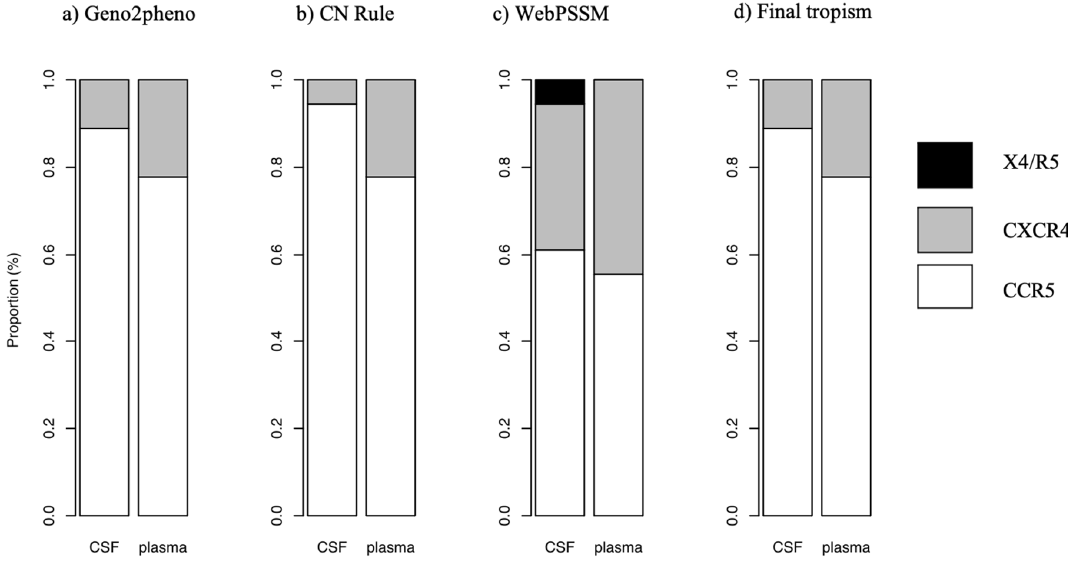
Figure 3. Comparison of co-receptor usage in CSF and plasma using ( a ) Geno2Pheno, ( b ) 11 / 25 rule (CN Rule) and ( c ) PSSM as well as the ( d ) final tropism based on the three methods.